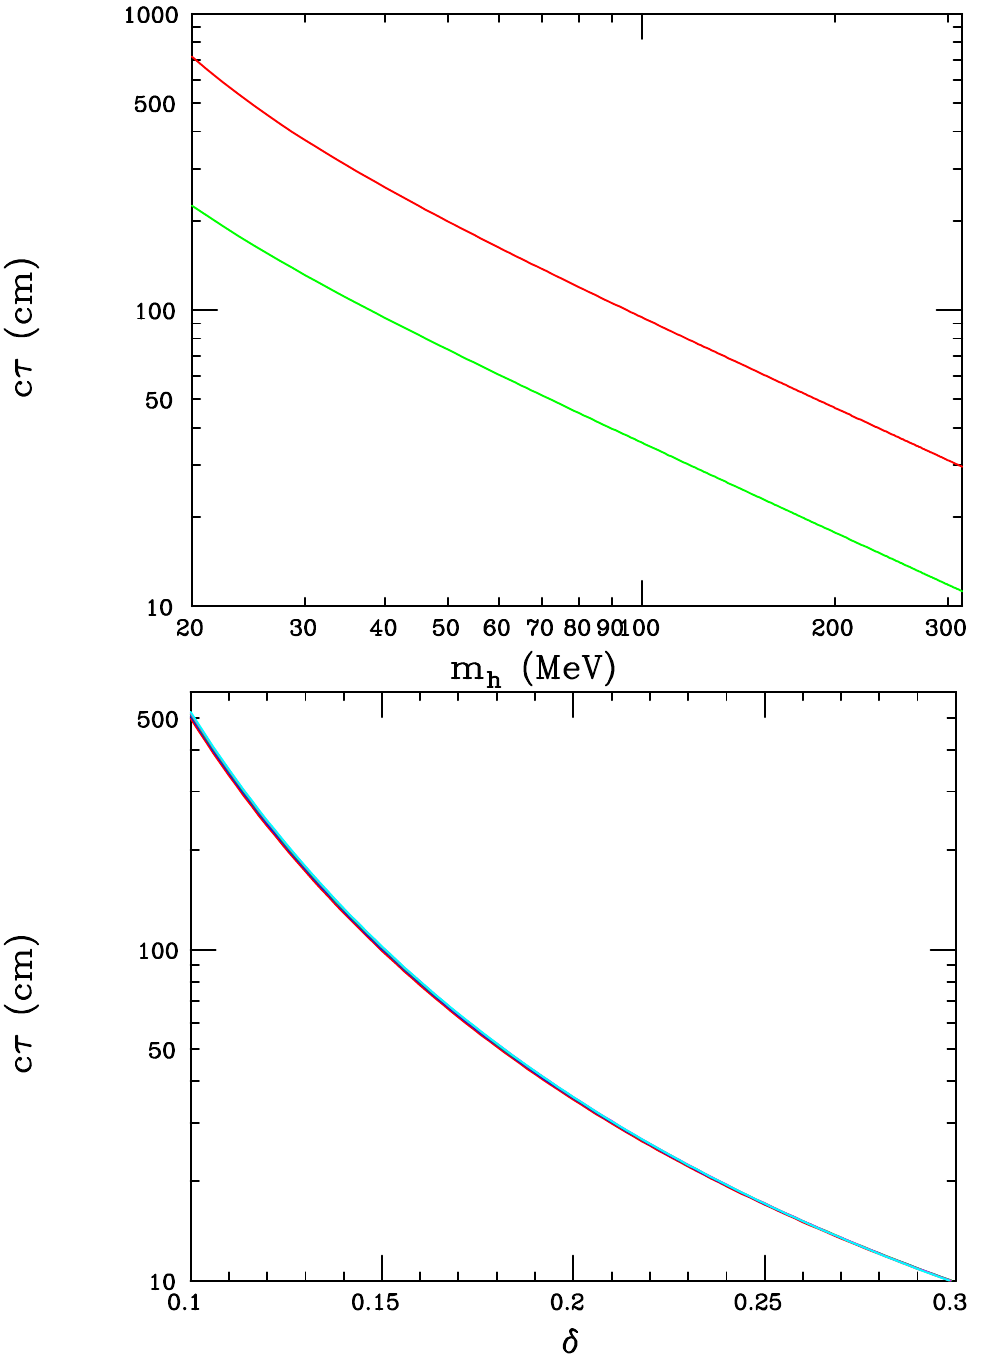
Figure 10 . Top: unboosted decay lengths for the a 1 in BM1(lower curve) and BM2(upper curve) as functions of m h . Bottom: (cid:14) -dependence of the a 1 decay length for m h 1 di(cid:11)erent choices of h = 0 : 1 (cid:0) 0 : 5, which essentially lie atop one another. Note that in both panels g D (cid:15) 1 = 10 (cid:0) 3 has been assumed.